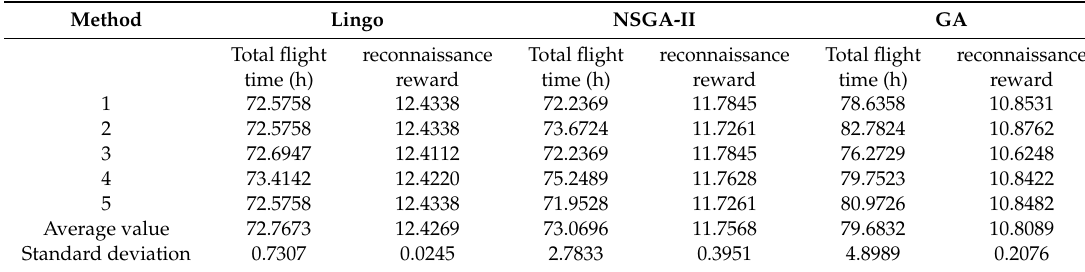
Table 3. Results of the three